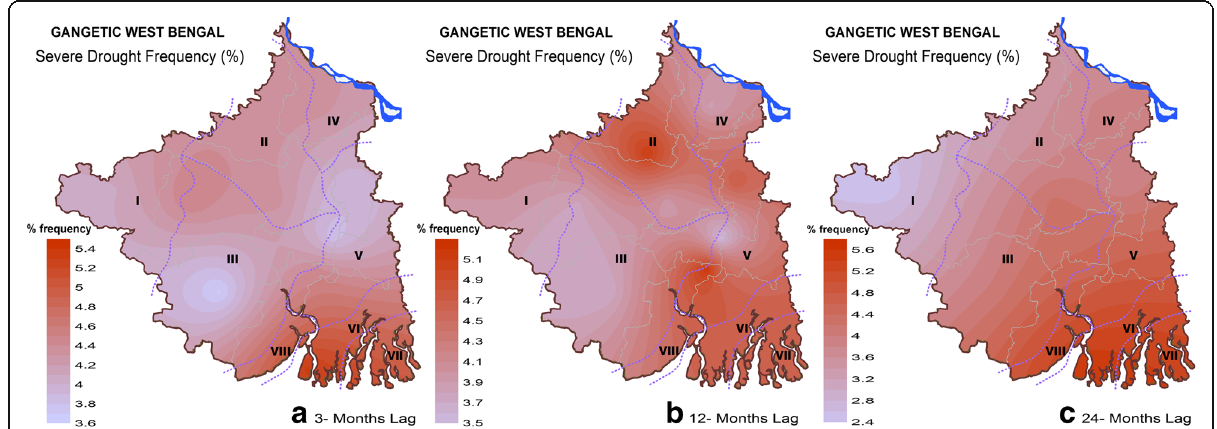
Fig. 10 Severe drought occurrences at ( a ) 3-, ( b ) 12- and ( c ) 24-month time